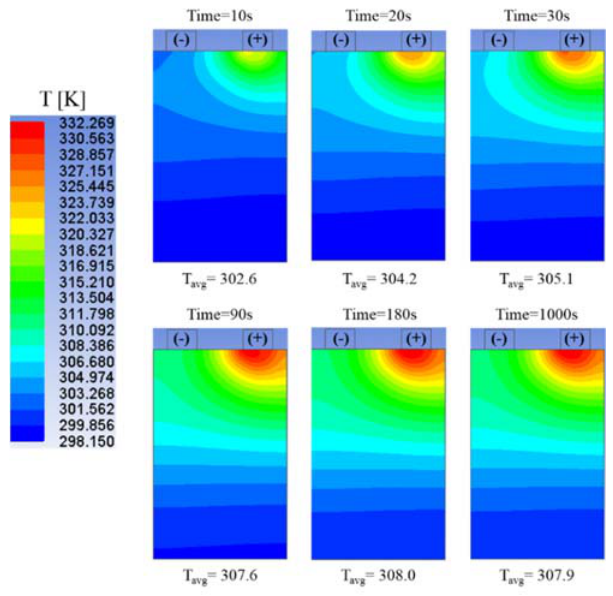
Figure 14. Temperature contours over the middle of the LFP electrode at a 2C rate for six different discharge elapsed times of 10 s, 20 s, 30 s, 90 s, 180 s and 1000 s.